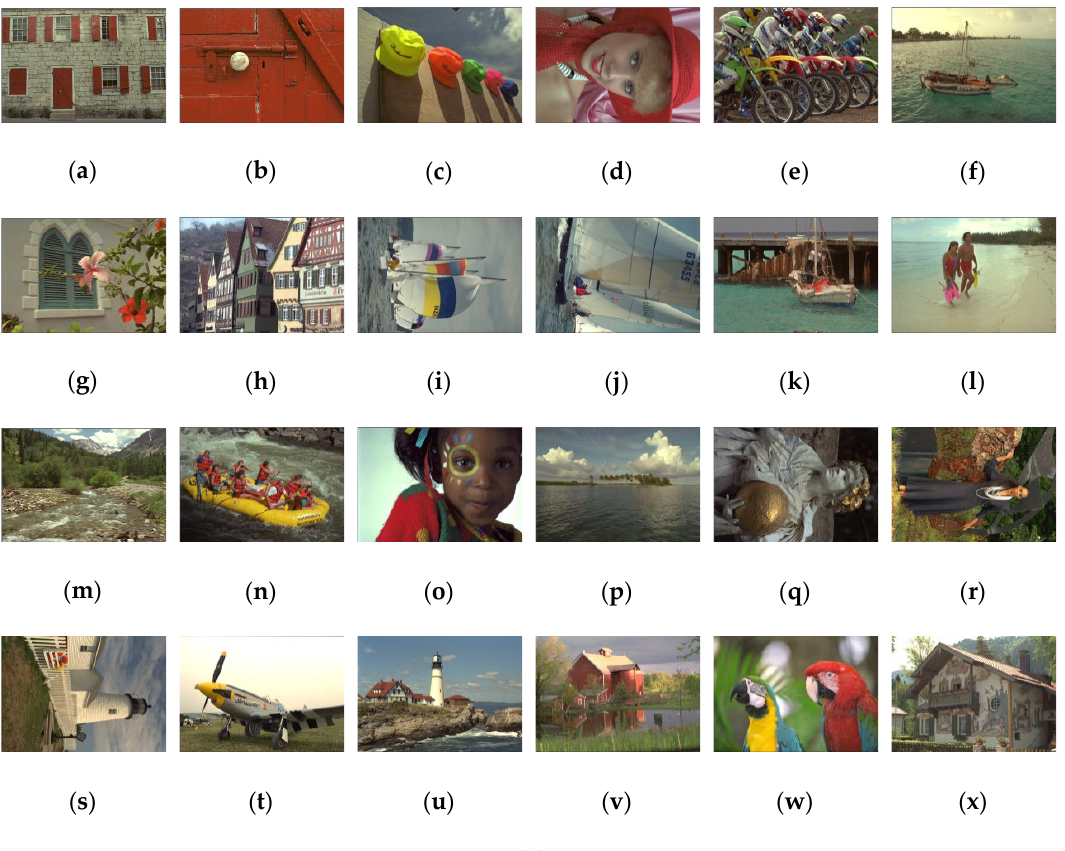
Figure 7. Kodak test images.